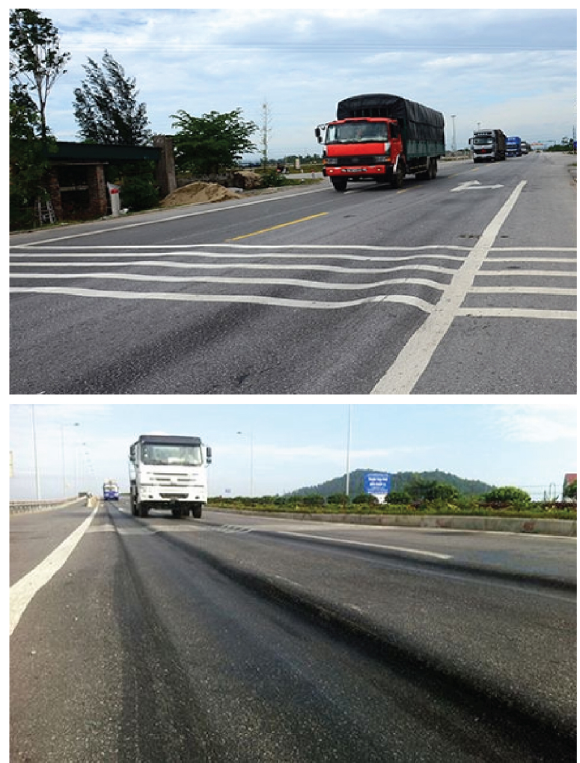
Figure 2: Rutting in National Highway 1, Vietnam. There are three basic types of asphalt pavement rutting: surface wear rutting, structural rutting and in- stability rutting. The types of asphalt pavement rutting are shown in Figure 3. The factors that influence the pavement rutting performance can be categorized into three groups: material properties, such as property of bitumen, binder content, aggregate property, etc.; climatic and traffic; and construction